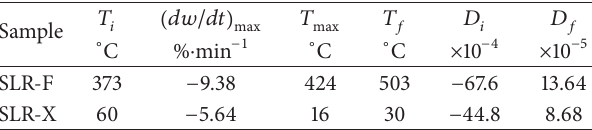
Table 4: Combustion characteristics of SLR-F and SLR-X.